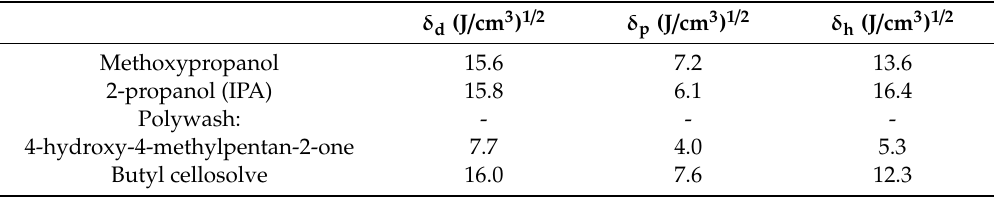
Table 1. Hansen solubility parameters of solvents used in